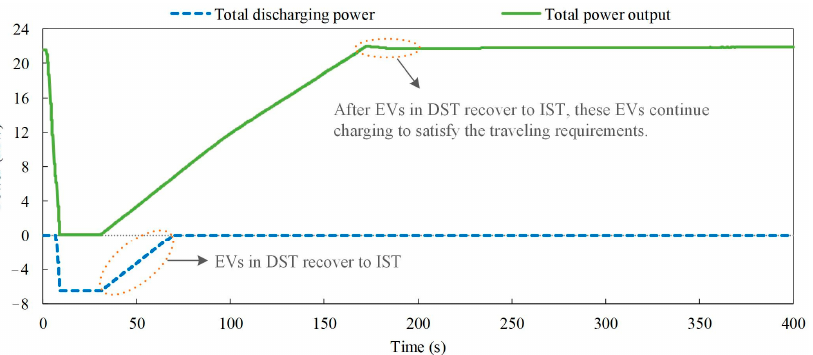
Figure 8. System frequency regulation without and with regulation recovery by the EV aggregator.